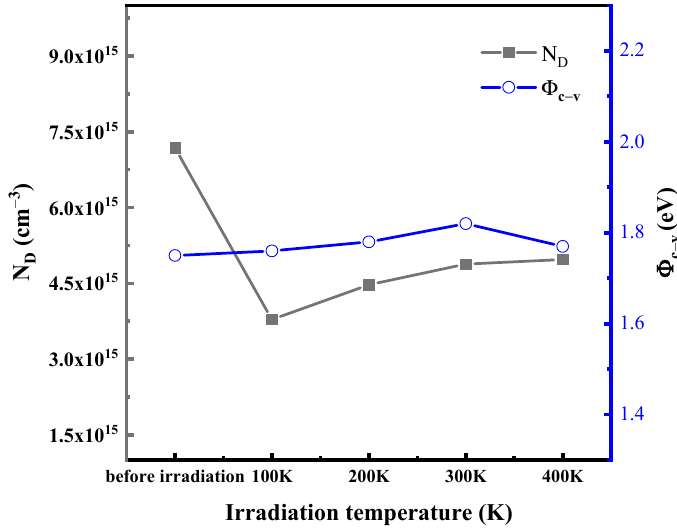
Φ c-v versus irradiation